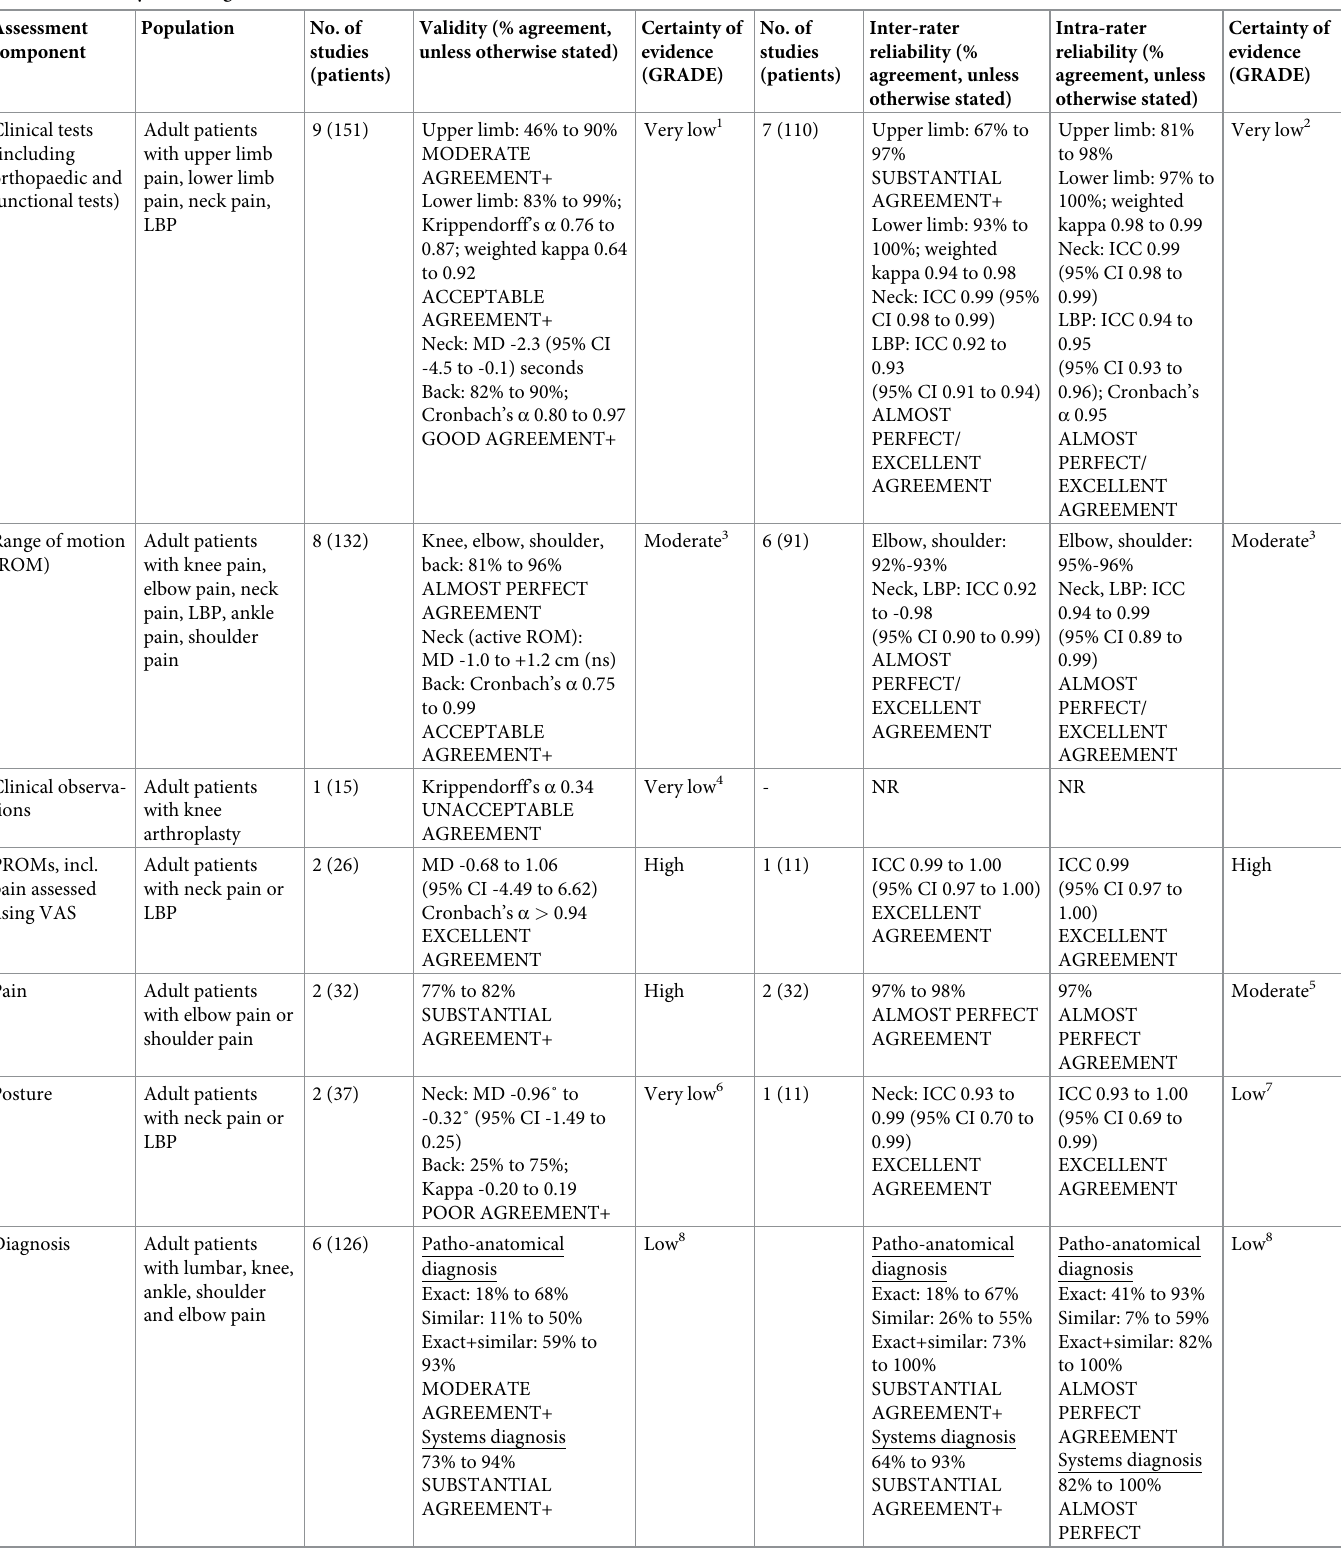
Table 5. Summary of findings and GRADE